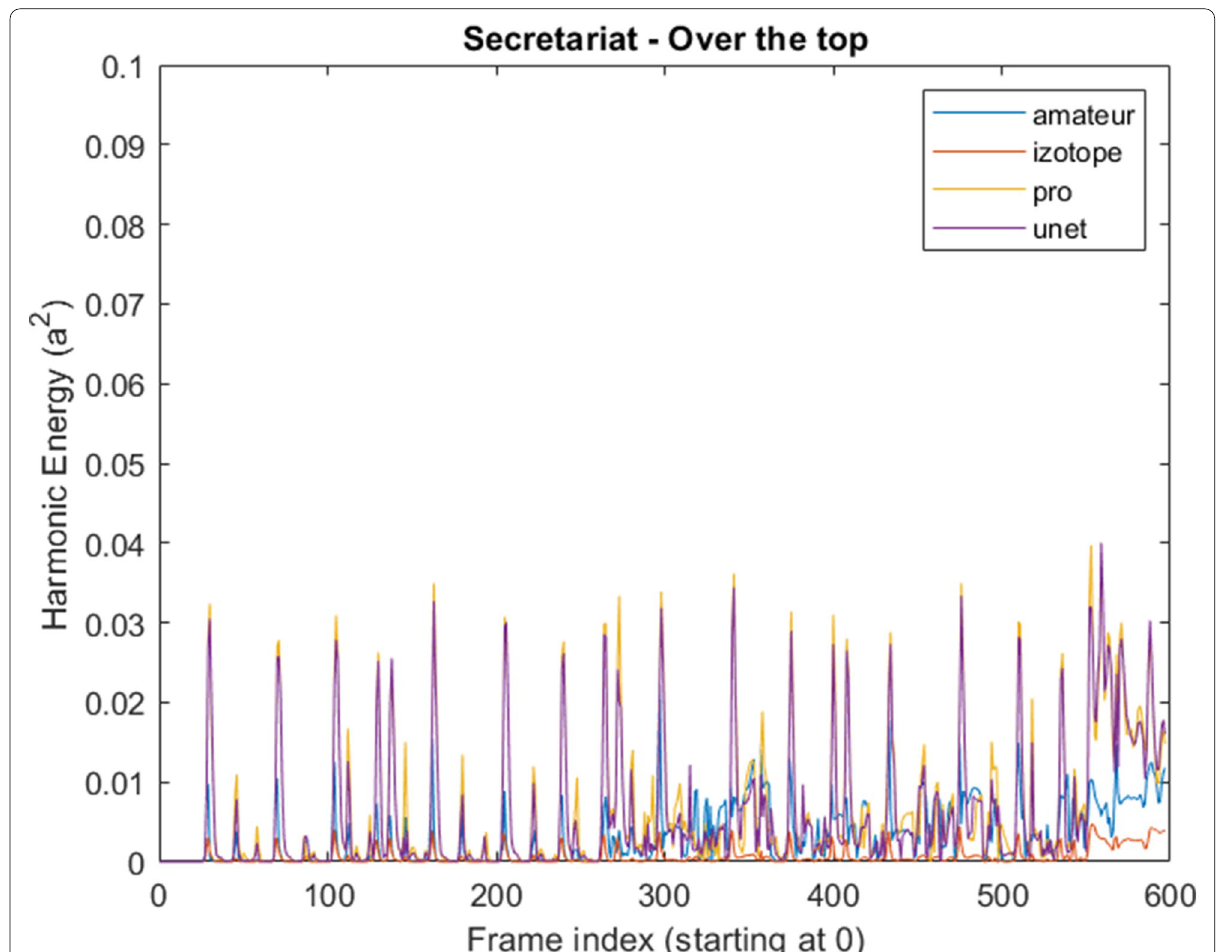
Fig. 8 Variation of the harmonic energy a 2 depending on the mix type in the “Secretariat—Over the top” song